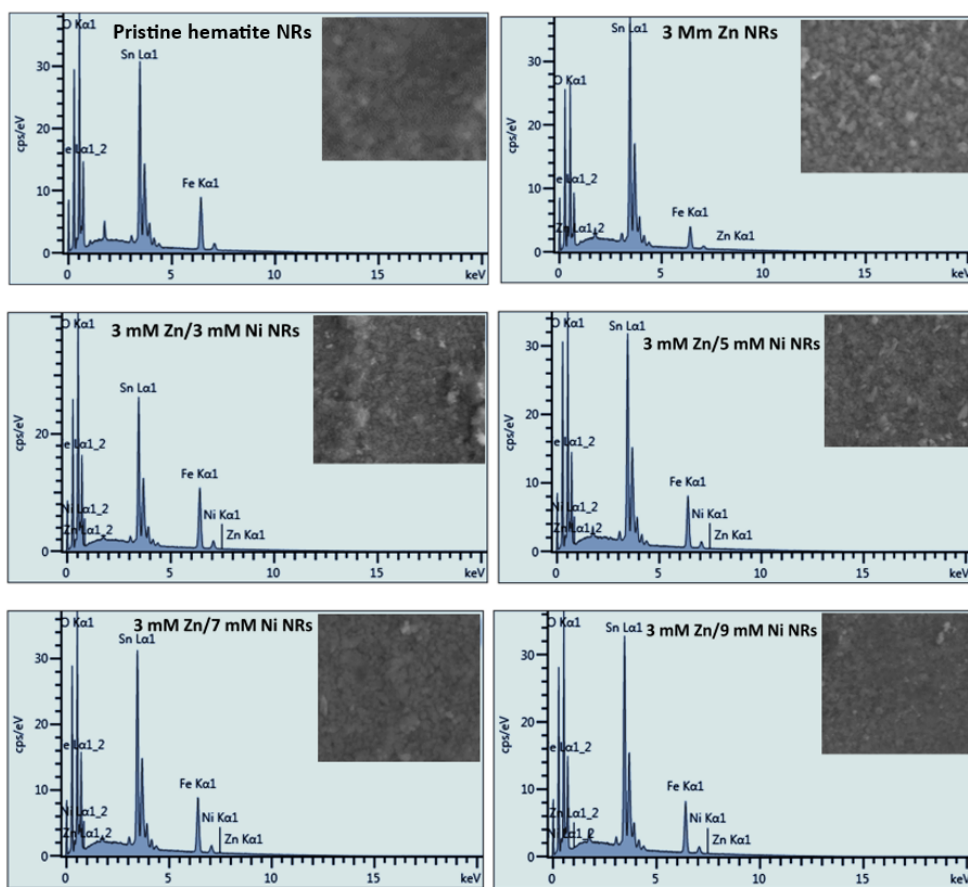
Figure 7. EDS analysis of pristine hematite and Zn- and Ni-doped NR samples. Table 1. Chemical atomic composition (at %) of the pristine and doped hematite NRs.